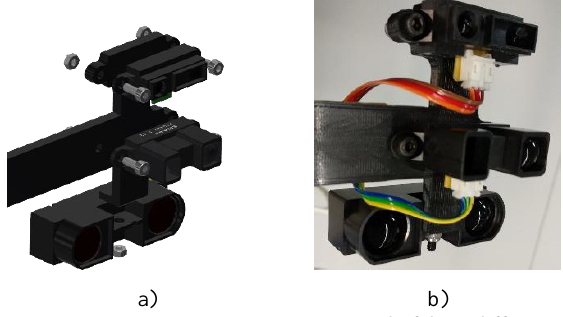
Figure 5. Measurement system composed of three different distance sensors. (a) CAD design. (b) Real system As can be seen in Table 1, with the three sensors, the distance meter system can measure in a continuous range from 4cm to 150cm. For the distance measurement in the overlap zone between sensors, the midpoint of the overlap is set as a limit for selecting the appropriate measurement. For example, the sensor GP2Y0A41SK0F will have a range in the system from 4cm to 25cm, and the GP2Y0A02YK0F sensor range would start at 25cm.